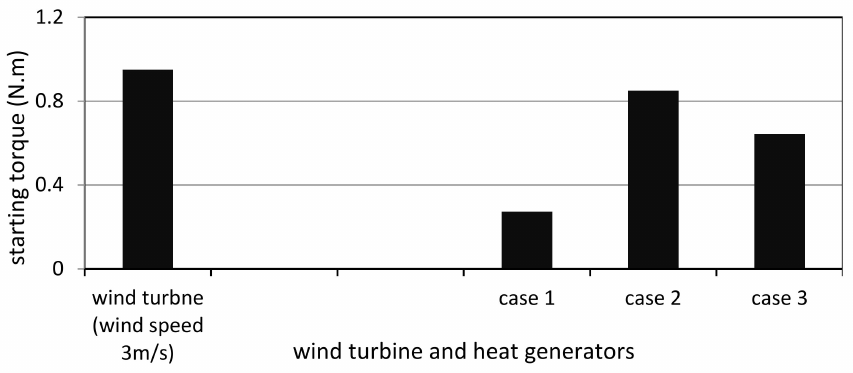
Figure 17. Comparison between torque needed to run PMECHs and wind turbine starting torque